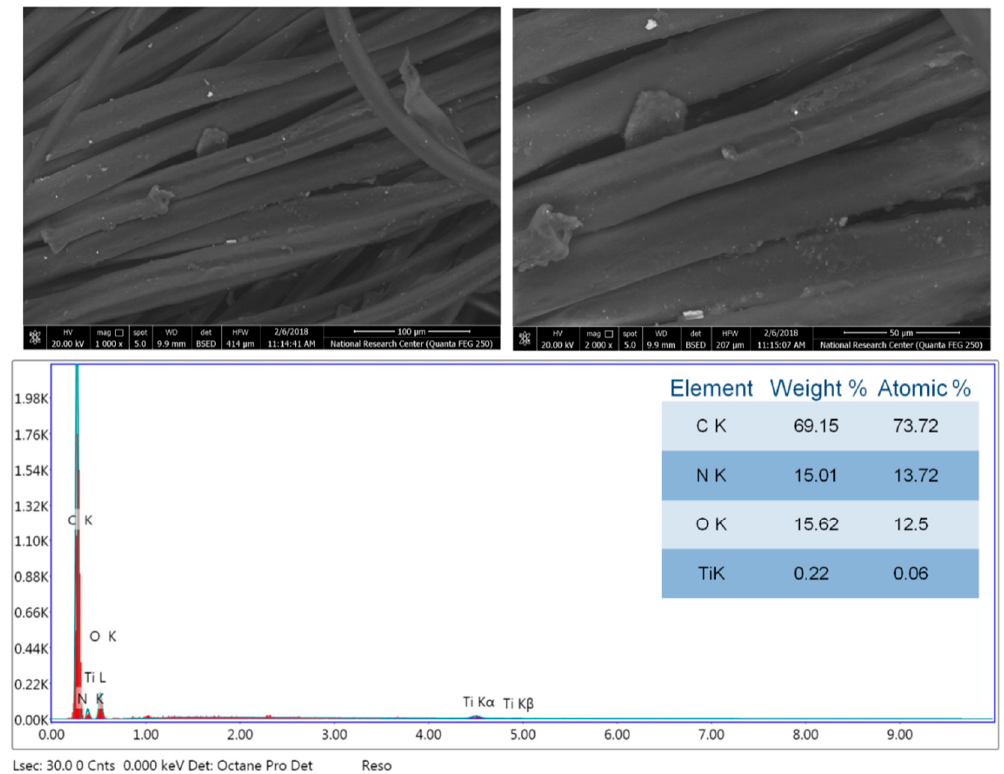
Figure 8. SEM images and EDX diagram of TiO 2 nanoparticles loaded onto a pre-treated acrylic fabric.